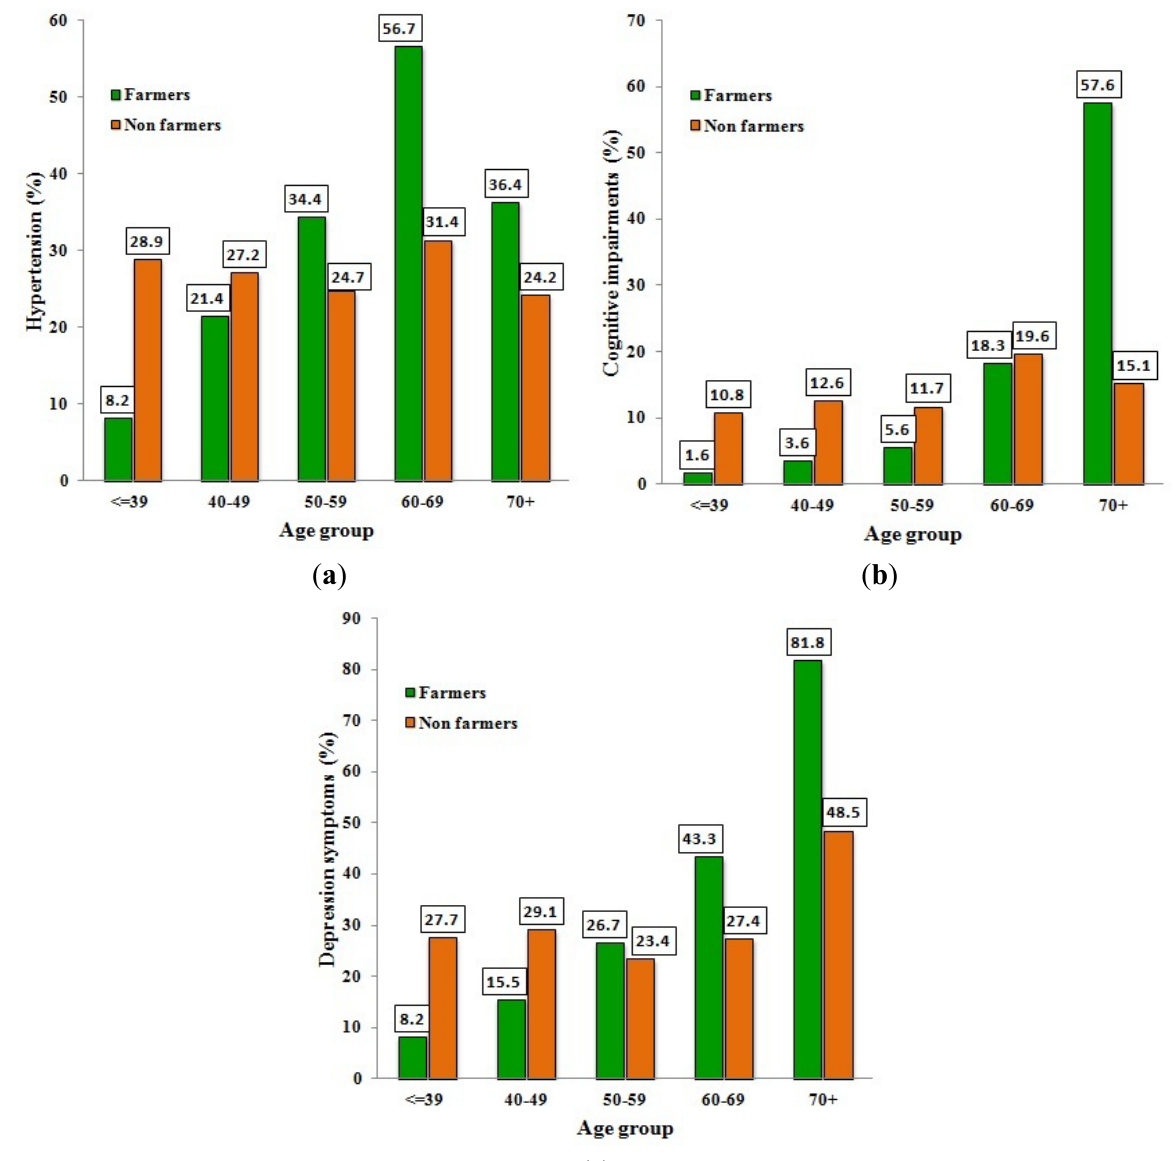
Figure 1. ( a – c ) Prevalence (%) of hypertension, cognitive impairments and depression symptoms in farmers and non-farmers per age